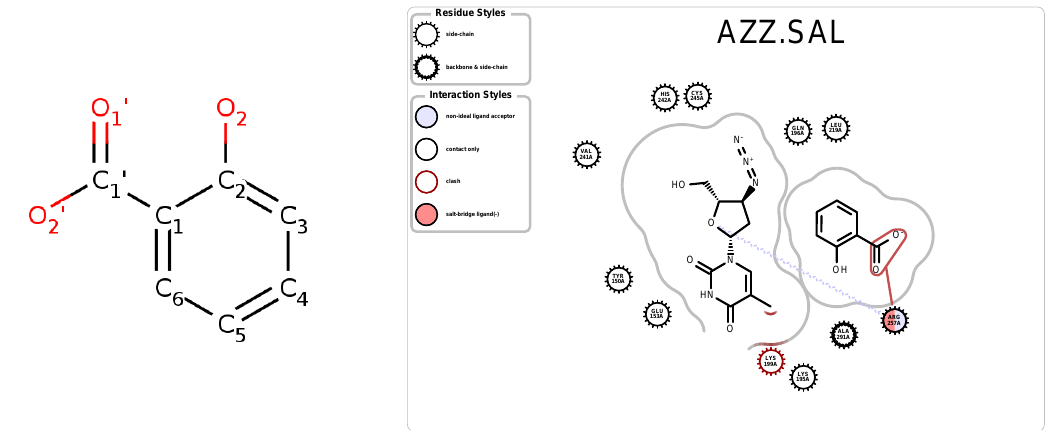
Figure 10. Salicyclic Acid ( left ), and schematic ( right ) of AZT and SAL in complex with HSA, PDB 3B9M.